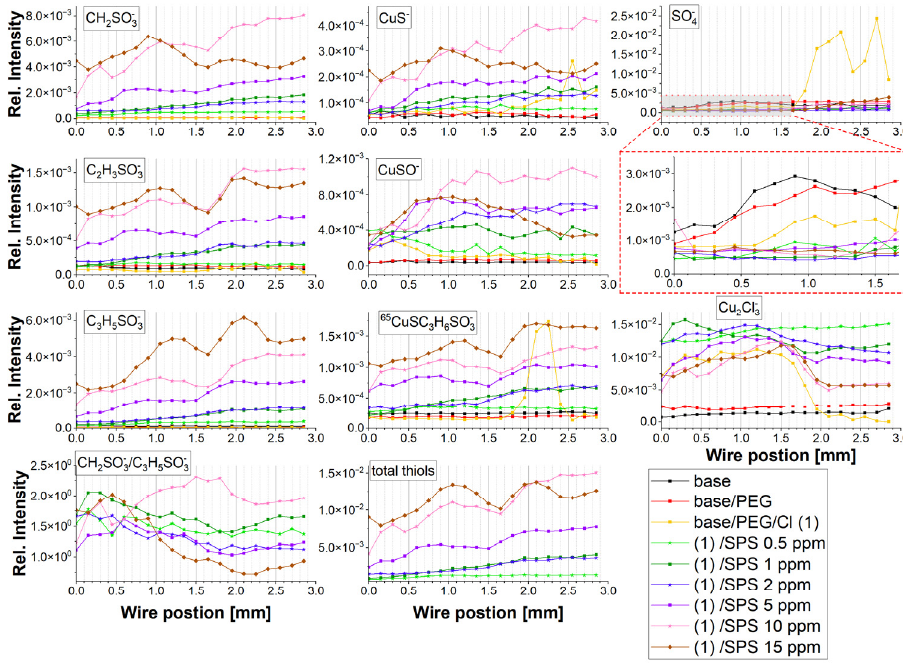
Figure 6. Distribution of the intensity of the fragments: CH 2 SO 3 − , CuS − , SO 4 − , C 2 H 3 SO 3 − , CuSO − , C 3 H 5 SO 3 − , CuSC 3 H 6 SO 3 − , Cu 2 Cl 3 − , the ratio of CH 2 SO 3 − /C 3 H 5 SO 3 − , and total thiols along with the wire position for the base electrolyte, base/PEG, base/PEG/Cl, and base/PEG/Cl/SPS at concentrations of 0.5, 1, 2, 5, 10, and 15 ppm. The wire position corresponds to the applied overpotential during the CV experiment.